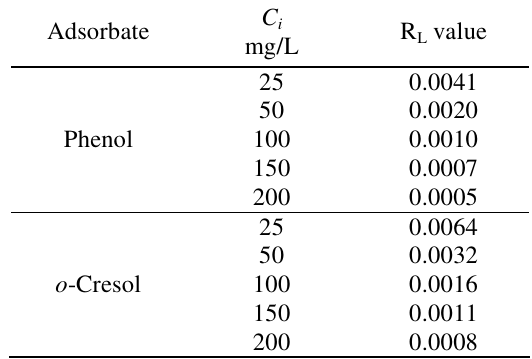
Table 2. R values for the adsorption of phenols on CC at 30 ° L